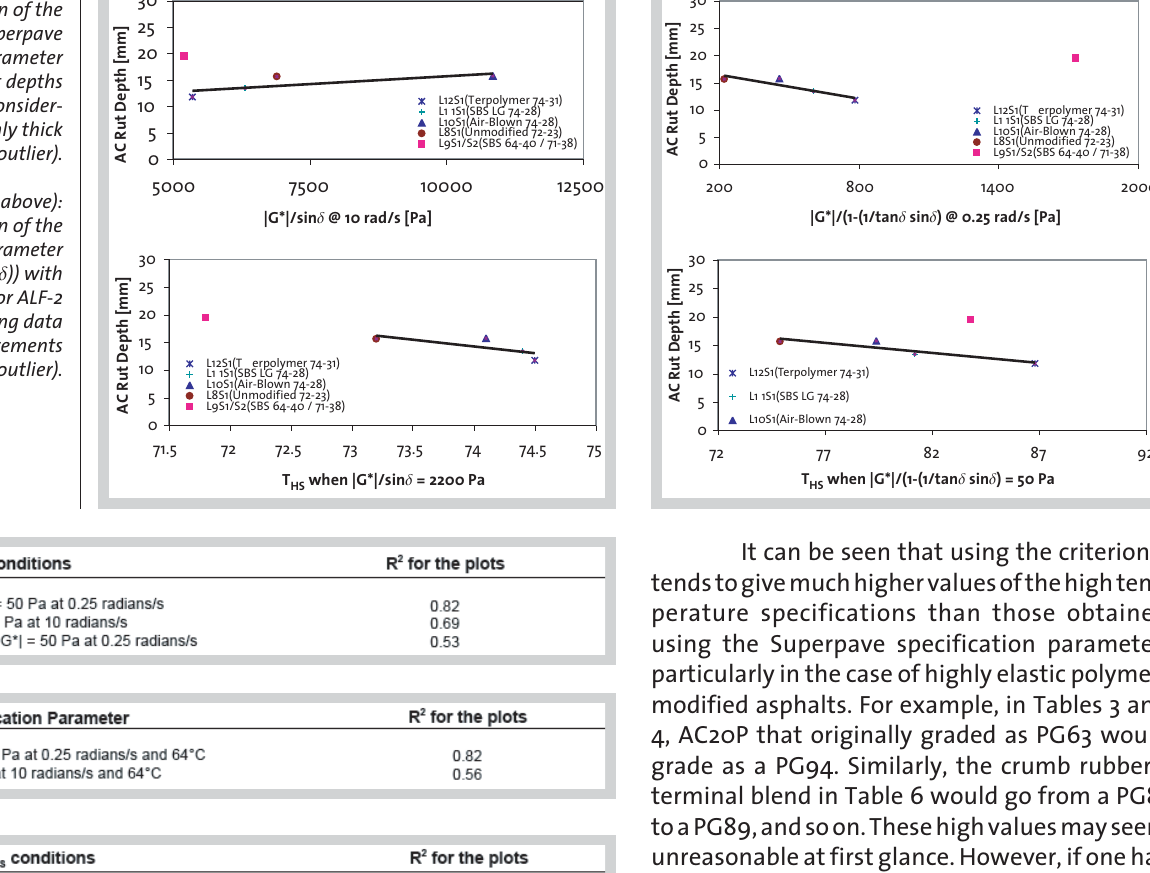
Table 7b (above): Correlation coefficients for the high specification temperature T HS for |G*|/sin d and the two criteria for |G*|/(1-(1/tan sin d )) with AC rut depth at 40,000 wheel passes for asphalt binders from the ALF-2 Project (Considering thick and thin pavements and 2 outliers). Table 8a (middle): Correla- tion coefficients for |G*|/sin d and |G*|/(1-(1/tan d sin d )) with AC rut depth at 40,000 wheel passes for asphalt binders from the ALF-2 Pro- ject (Considering only thick pavements and 1 outlier). Table 8b (below): Correlation coefficients for the high specification temperature T HS for |G*|/sin d and the two criteria for |G*|/(1-(1/tan d sin d )) with AC rut depth at 40,000 wheel passes for asphalt binders from the ALF-2 Project (Considering only thick pavements and 1